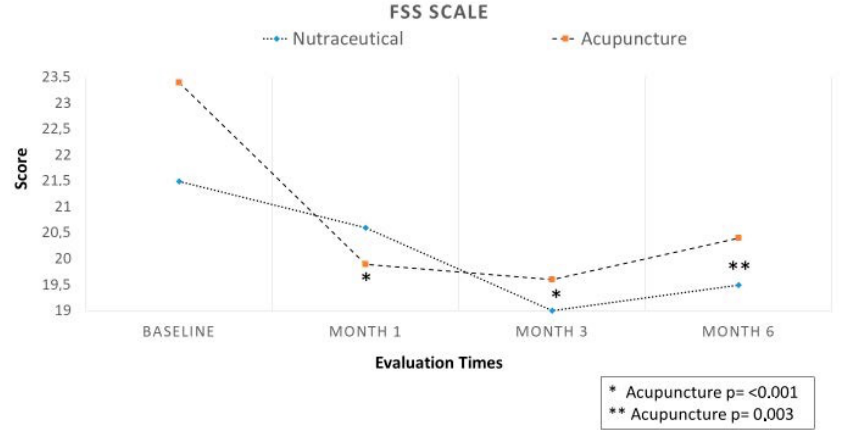
Figure 5. Secondary efficacy end-point in analyzed population: change in Fibromyalgia Severity Scale (FSS) score during observation. The evaluation shows a statistically significantly score reduction only in the Acupuncture Group in all the observations ( p < 0.0001). Nutrients 2020 , 12 , 821